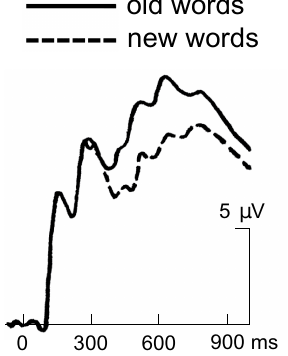
Fig. 4. An example of an old-new ERP difference (also known as an ERP repetition effect) obtained during a yes-no recognition test. The ERPresponse to old words was more positive than that to new words, beginning about 400 ms after word onset (from results obtained by Paller, Kutas, and Mayes [89]). Recordings were made from the midline parietal scalp location and positive potentials are shown as upward